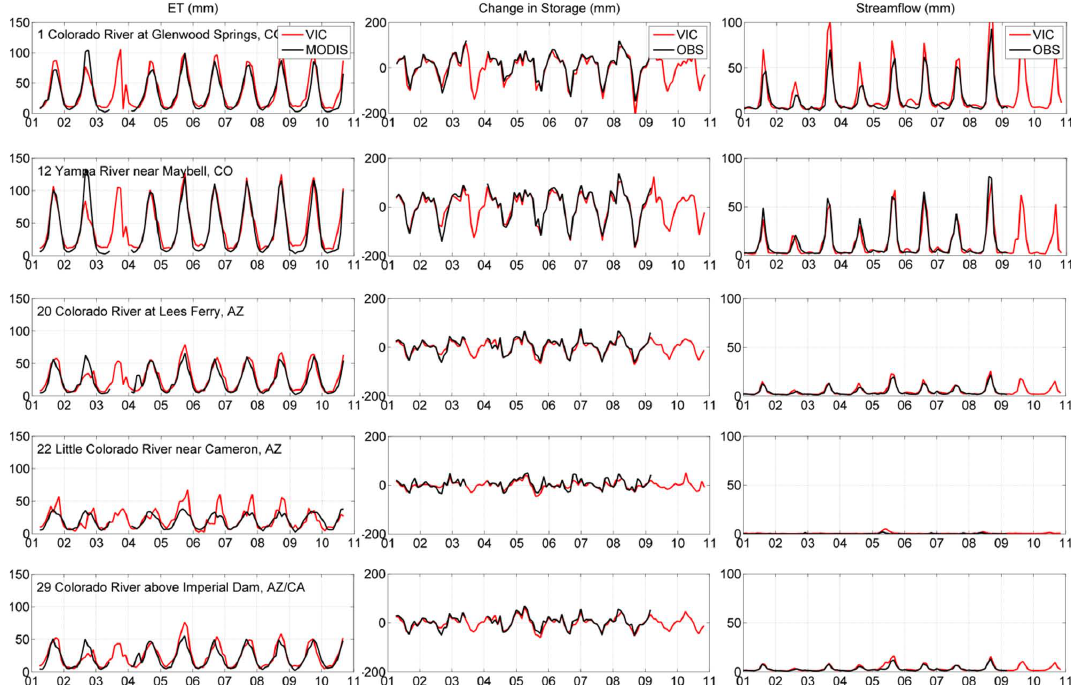
Fig. 6. Comparisons between MODIS-derived and VIC ET (left), results of the basin-scale water balance (middle), and comparisons between simulated and observed streamflow (right) for selected